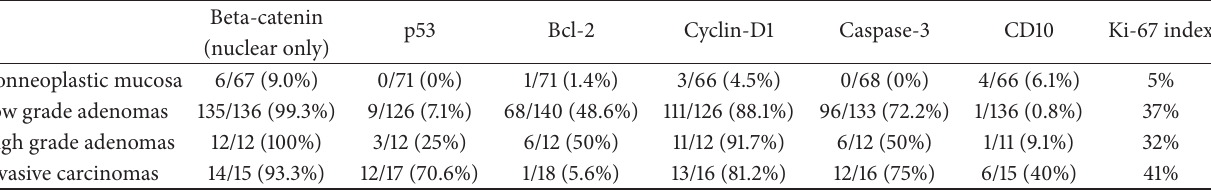
Table 2: Frequency of expression of beta-catenin, bcl-2, cyclin-D1, caspase-3, CD10, and Ki-67 in nonneoplastic mucosa, adenomas, and